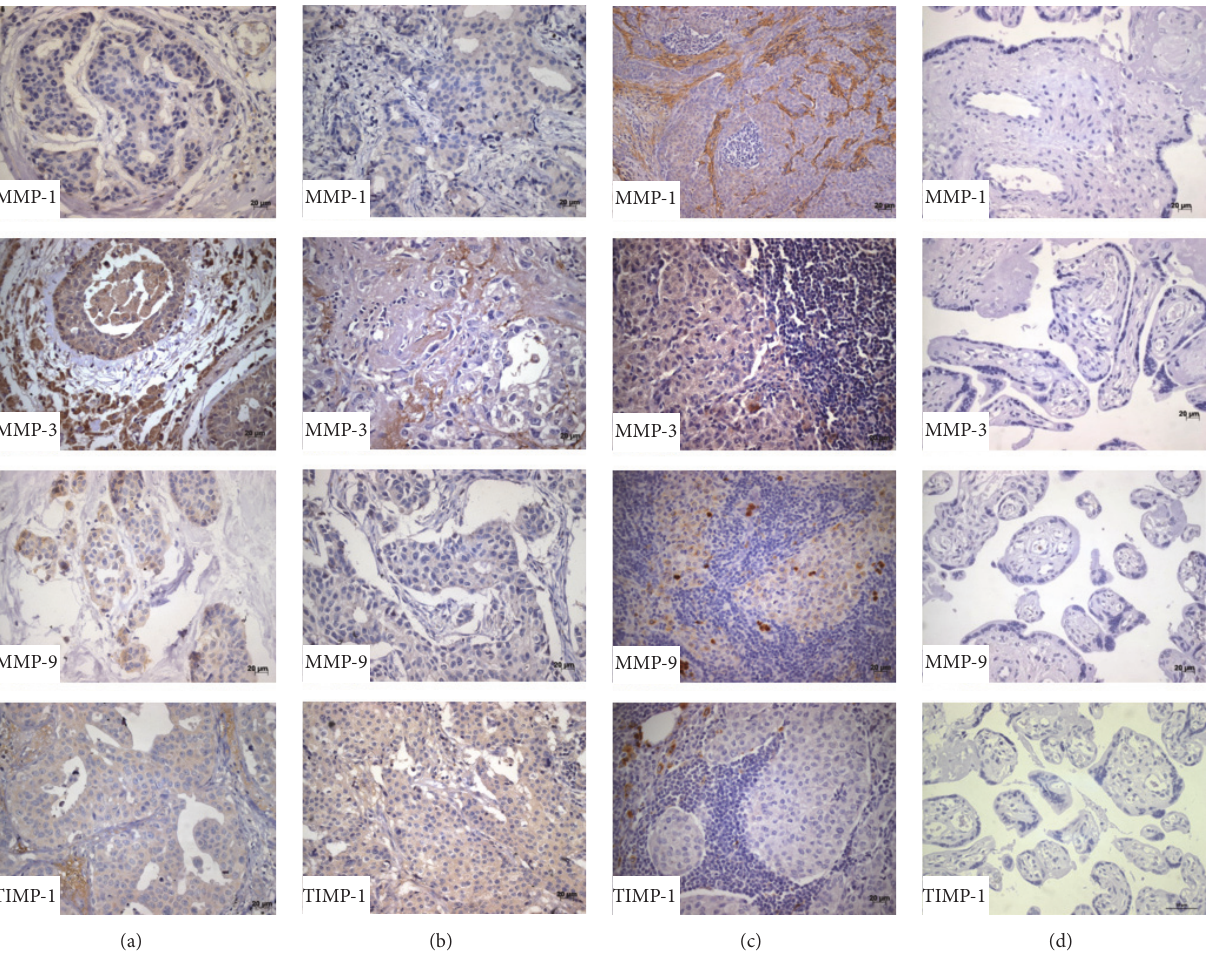
Figure 1: Expression of matrix metalloproteases in samples with ductal breast cancer and metastatic ganglia. Immune-chemistry with labeled matrix metalloproteinases MMP-1, MMP-3, MMP-9, and the metalloproteinase tissue specific inhibitor TIMP-1 in ductal breast cancer samples; (a) with metastasis, (b) without metastasis, (c) metastatic lymphatic ganglia diagnosed by trans-surgical H&E, and (d) placental tissues were negative controls. Magnification